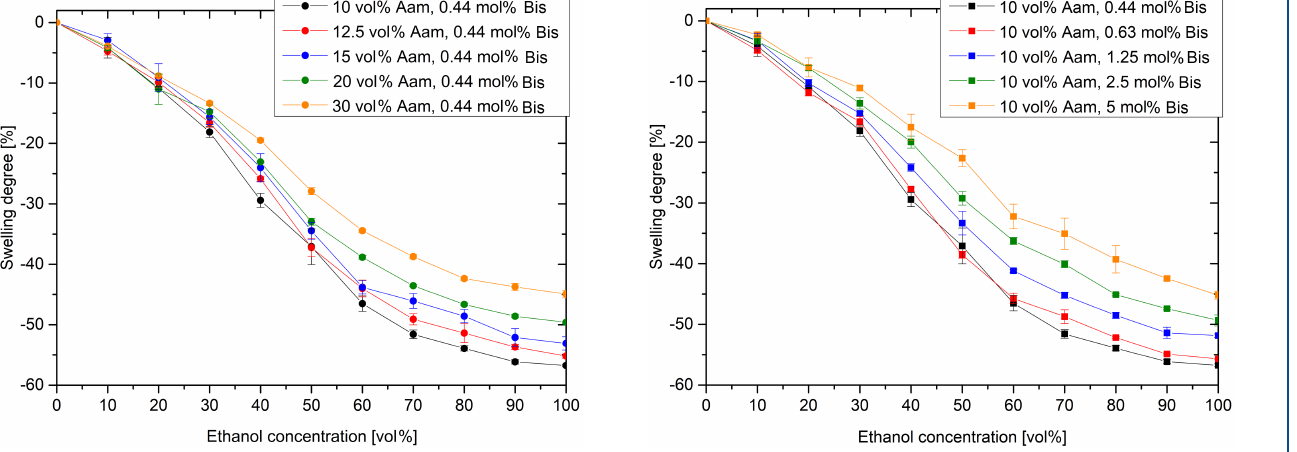
Figure 7. Influence of the acrylamide concentration on the swelling degree of the hydrogels.